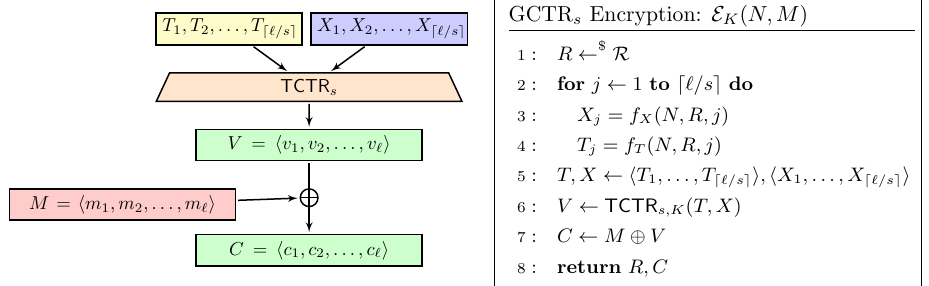
Figure 6: GCTR s mode redefined with TCTR. This definition is equivalent with the definition presented in Sect. 4.1.